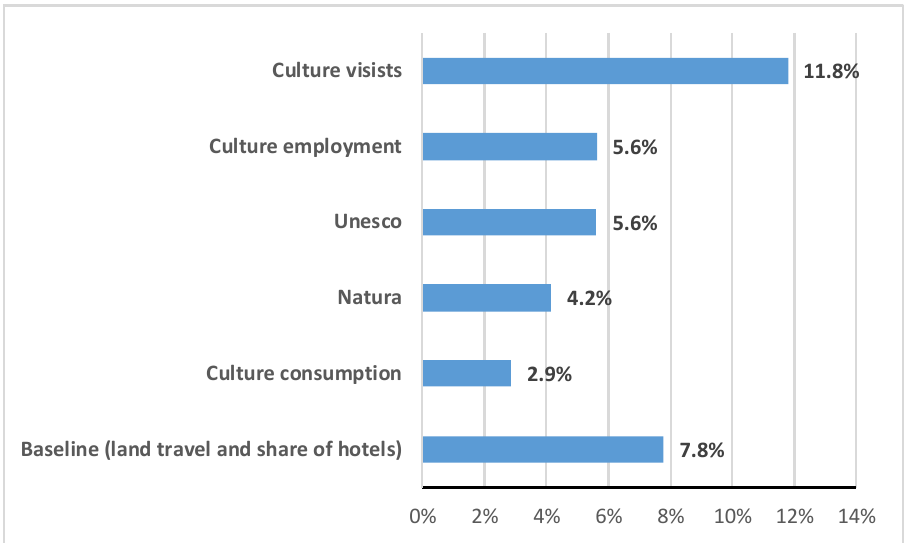
Figure 3. Percentage points of coefficients of determination added on average to the simple regression for 7 months by the baseline multiple regression, and further 5 regressions for the 20 countries under review. Source: Author’s calculation, using data specified in the Data Availability Statement.